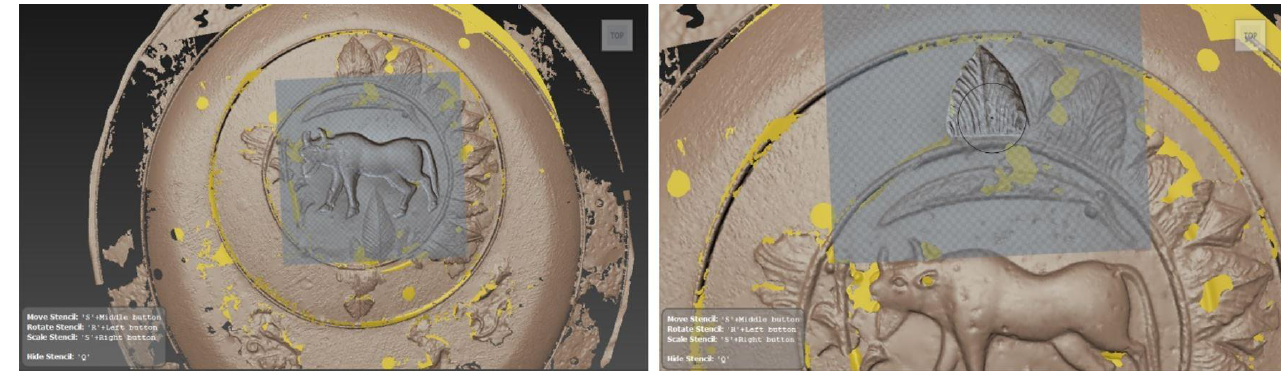
Figure 19. Applying the vector displacement map stencil on the 3D reconstructed support.